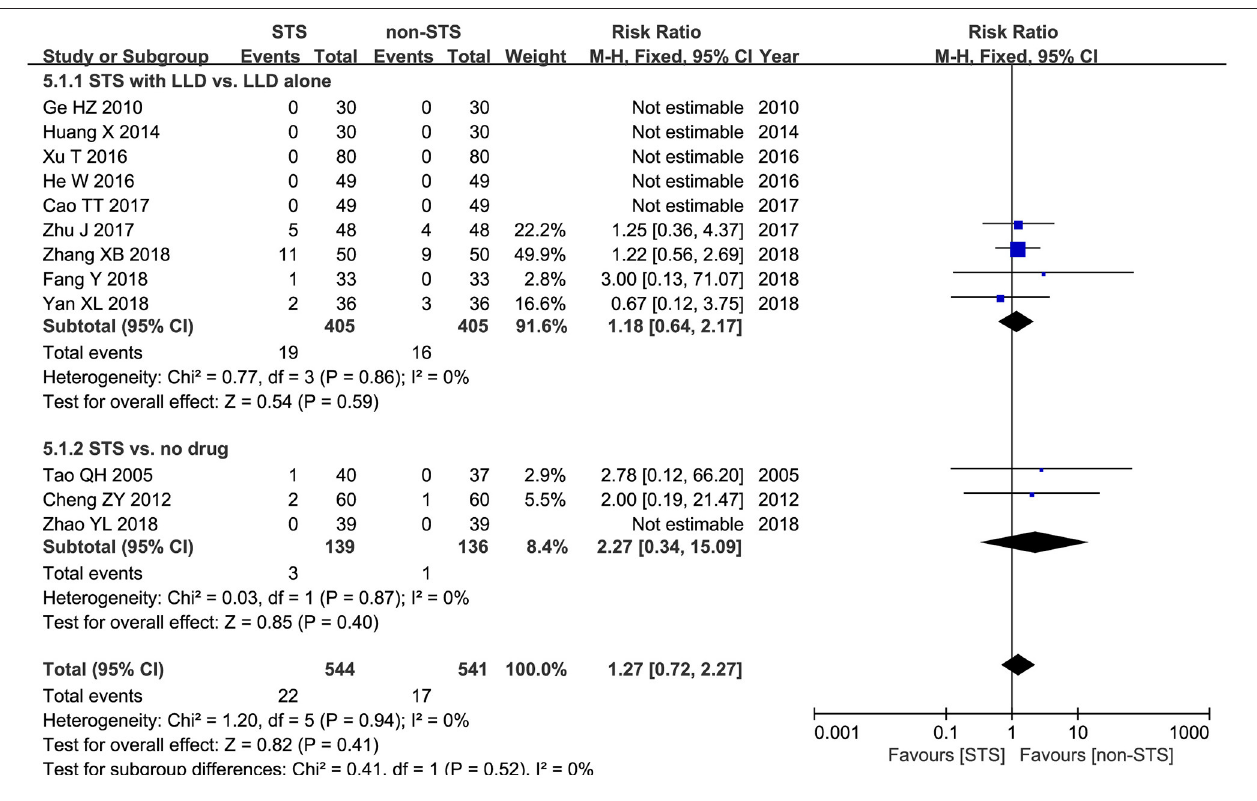
FIGURE 7 | Forest plot of comparison: STS vs. non-STS in AEs.